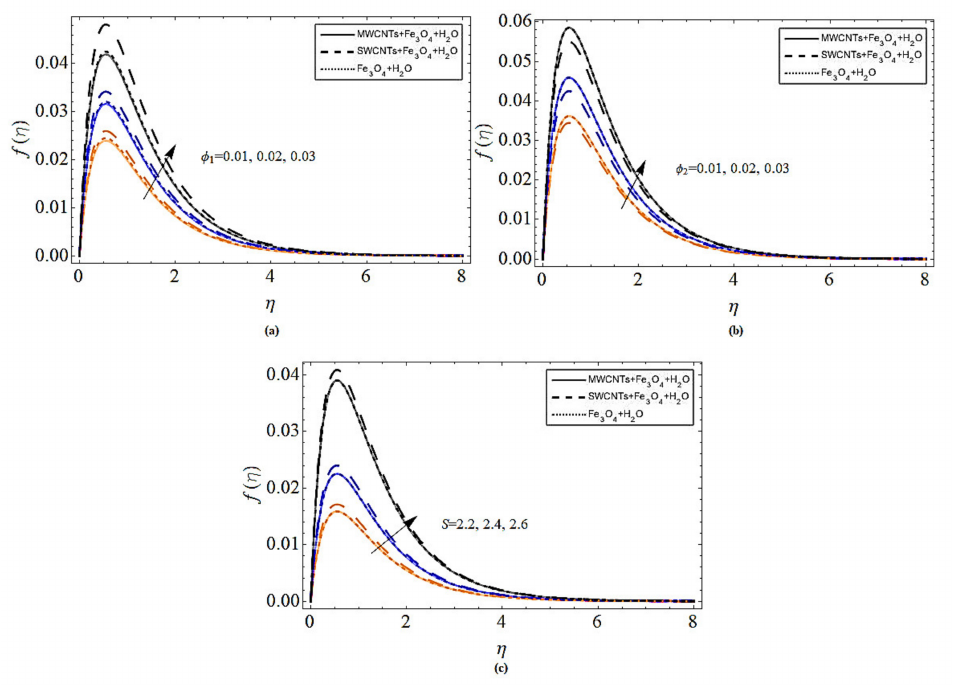
Figure 2. The behavior of axial velocity f ( η ) versus ( a ) volume friction parameter of CNTs φ 1 ( b ) volume friction parameter of ferric oxide φ 2 ( c ) disk fluctuation parameter S